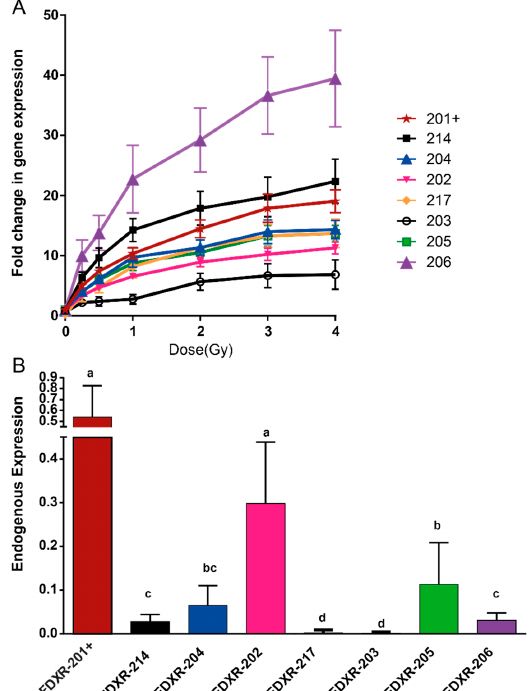
Figure 1. Gene expression of ferredoxin reductase (FDXR) variants in human blood from 10 healthy donors after X-ray irradiation ex vivo ( A ) and at endogenous level ( B ). Blood from five women and five men was exposed to a range of x-ray doses (0.25, 0.5, 1, 2, 3, 4 Gy; dose rate 0.5 Gy / min) and incubated for 24 h at 37 ◦ C. The data are presented as mean values ± standard error of the mean (SEM). One-way ANOVA followed by Tukey’s test was performed for statistical analysis. Values not sharing a common letter are significantly di ff